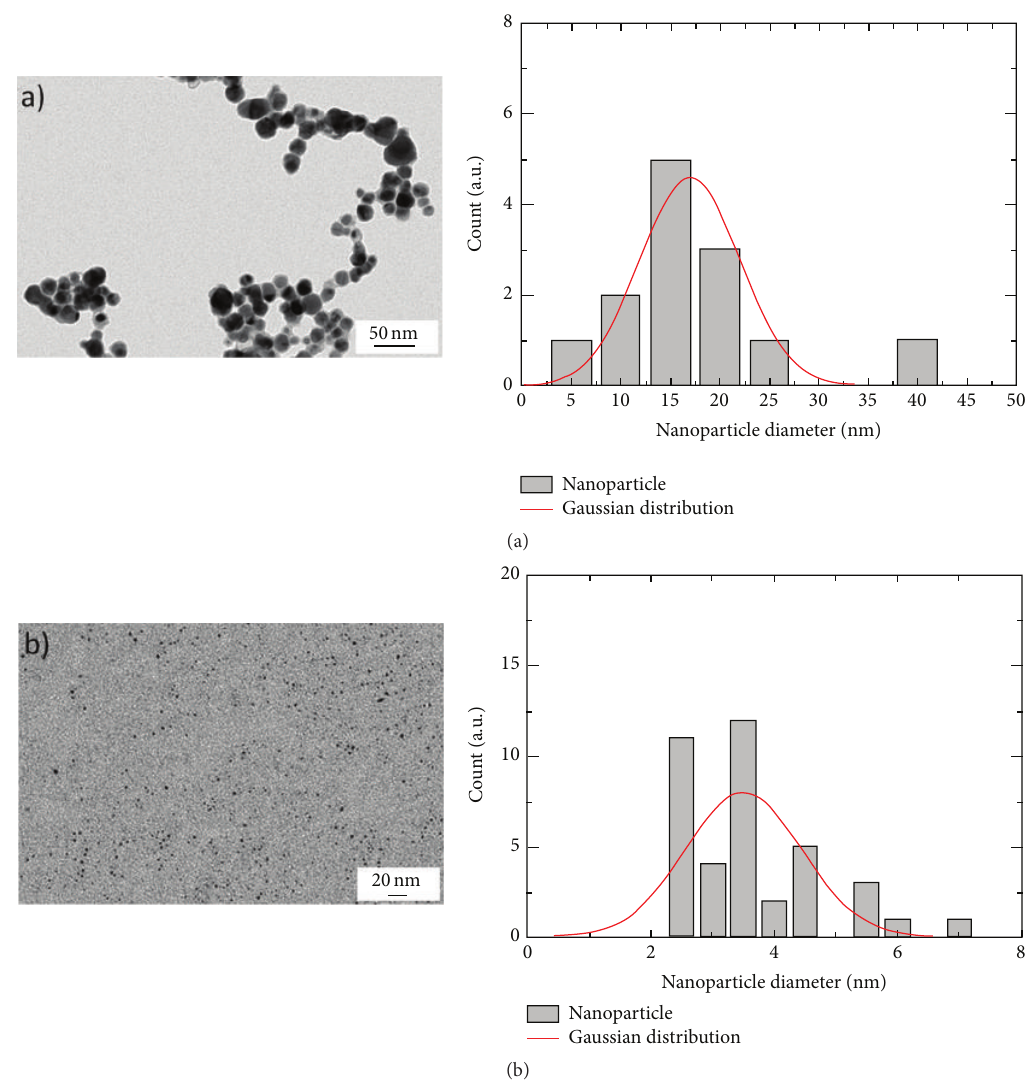
Figure 2: TEM analyses of the ligand-free Ag colloidal solution prepared by picosecond laser ablation of silver target in deionized water using different laser wavelengths: (a) 1064nm and (b) 355 nm. On the right side the corresponding size histogram is